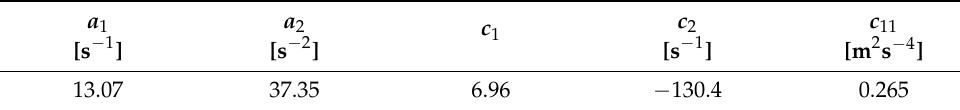
Table 7. Coefficients of attached linear system for std acceleration.